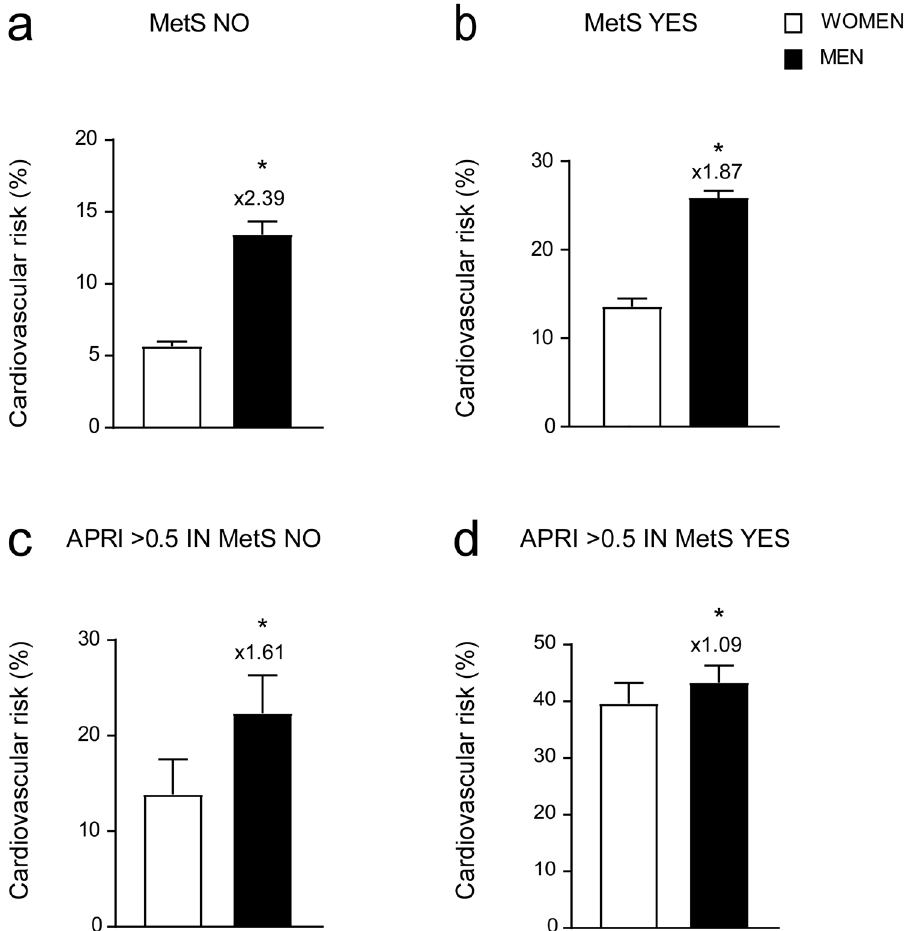
Figure 5. Gender-based comparison of cardiovascular risk in different groups. ( a – d ) T-Test comparison of CVR in non-metabolic (MetS NO) ( a ), MetS (MetS YES) ( b ), non-metabolic (MetS NO) with APRI > 0.5 ( c ) and MetS (MetS YES) subjects with APRI > 0.5 ( d ). Subjects were divided based on gender. Data is presented as mean ± SEM. Statistical significance was assessed by Student T-test (**p < 0.01). Multipliers are shown to identify difference in CVR in males compared to